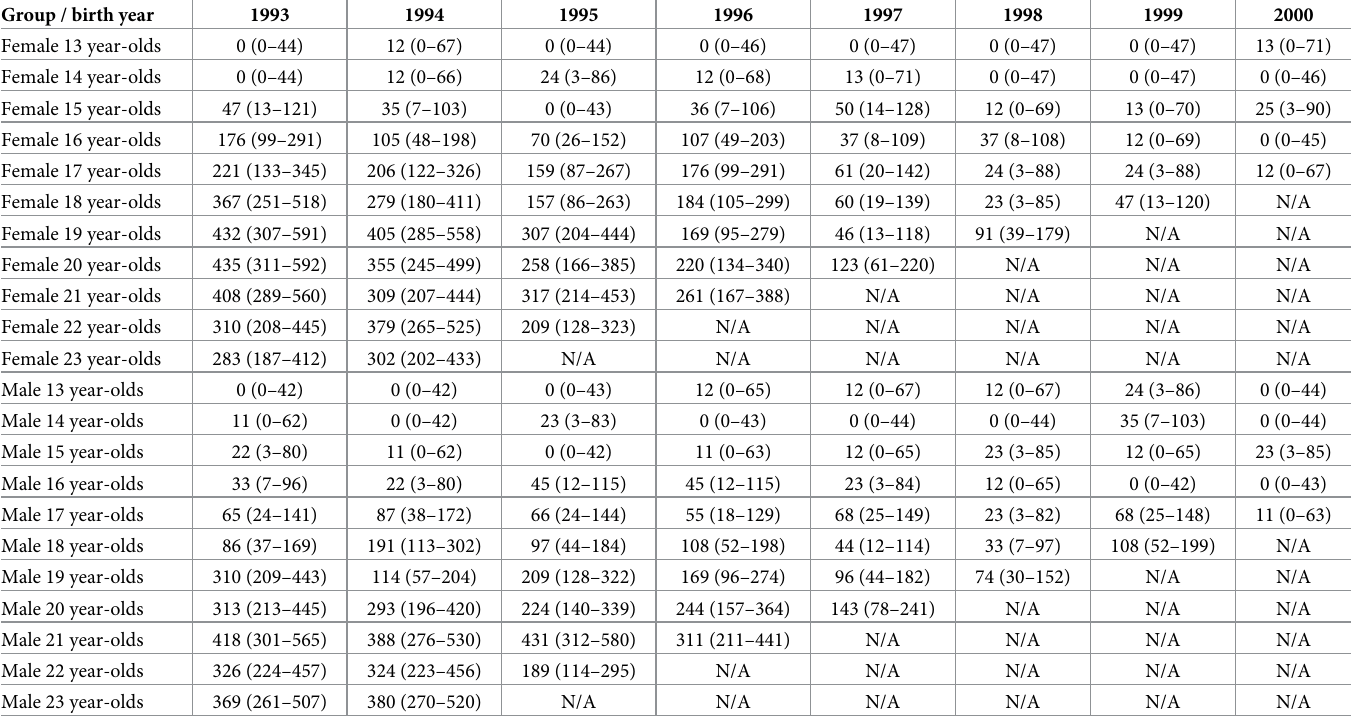
Table 1. Crude incidence rates (per 100,000 person-years; 95% confidence interval) of anogenital warts among birth cohorts by age and gender.